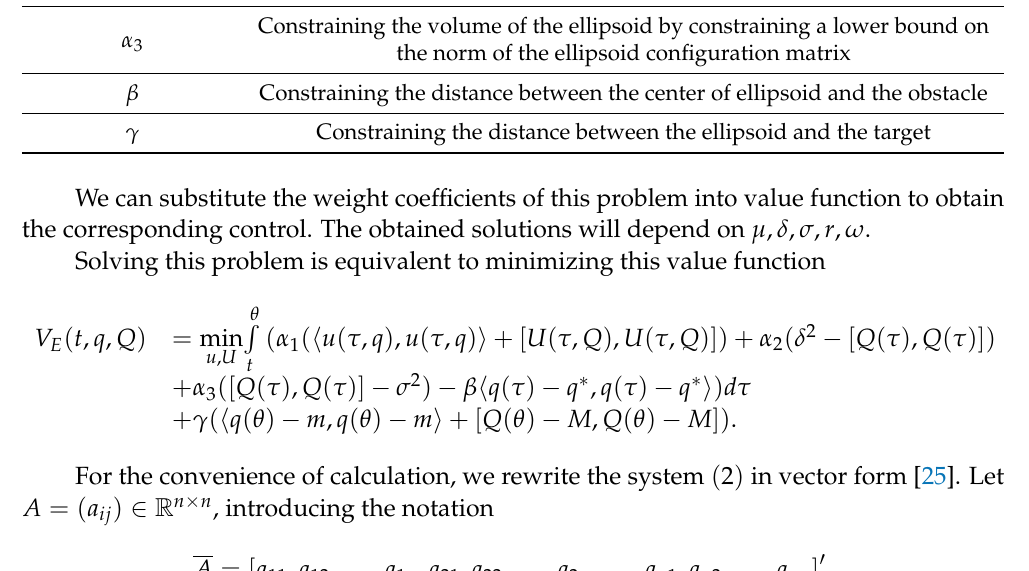
Table 1. Details of all the parameters. α 1 Constraining controls of the ellipsoid Constraining the volume of the ellipsoid by constraining an upper bound α 2 on the norm of the ellipsoid configuration matrix Constraining the volume of the ellipsoid by constraining a lower bound on α 3 the norm of the ellipsoid configuration matrix β Constraining the distance between the center of ellipsoid and the obstacle γ Constraining the distance between the ellipsoid and the